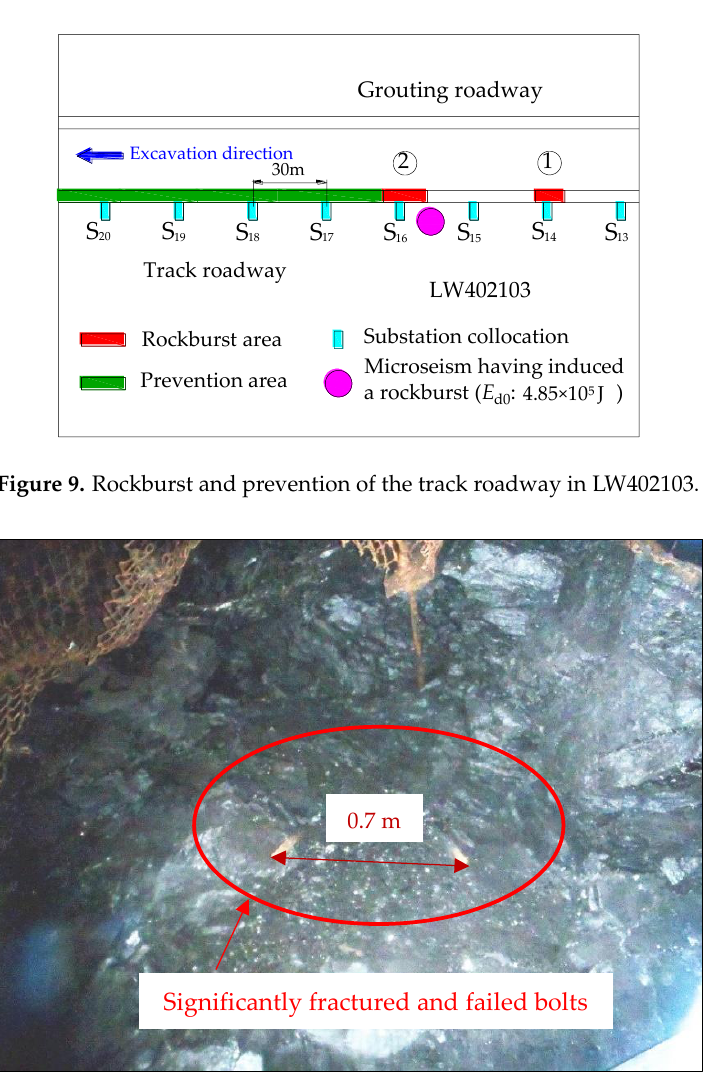
Figure 10. In situ failures of a rockburst (occurring at 19:34 p.m. on 18 April 2014). Table 4. Rockburst occurrence of track roadway in LW402103.